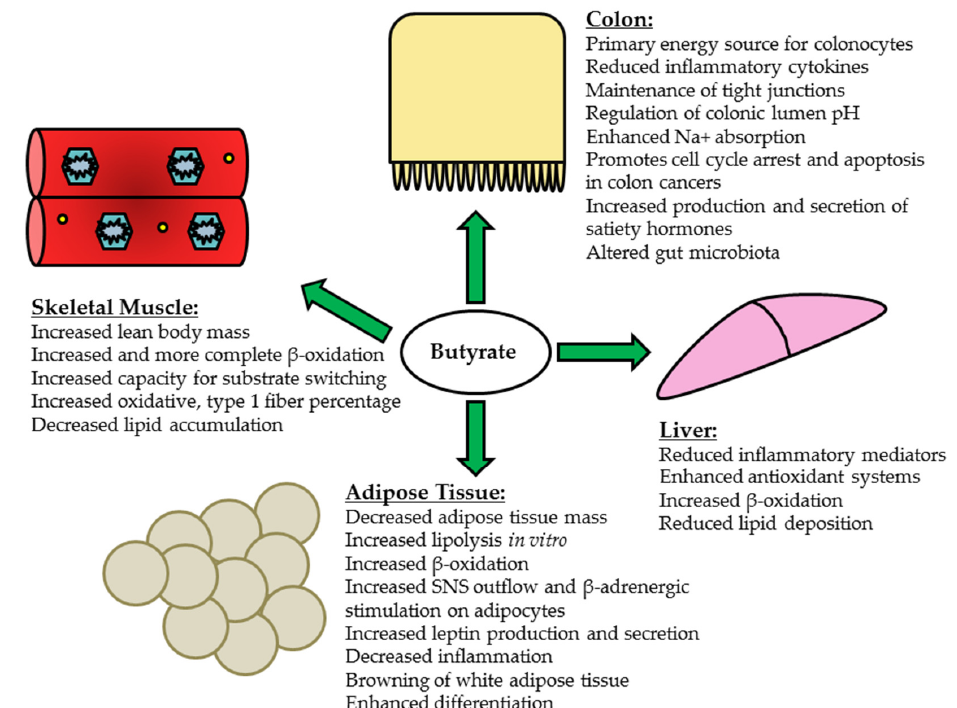
Figure 1. Summary of principle effects of butyrate and its potential mechanisms of action in the colon and peripheral tissues; liver, skeletal muscle and adipose tissue.